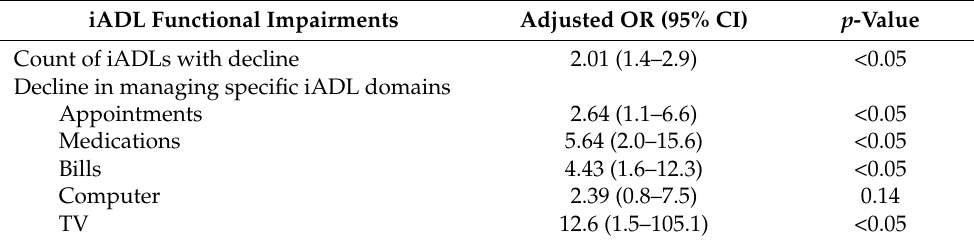
Table 3. Associations between iADL impairment and being referred to the driving